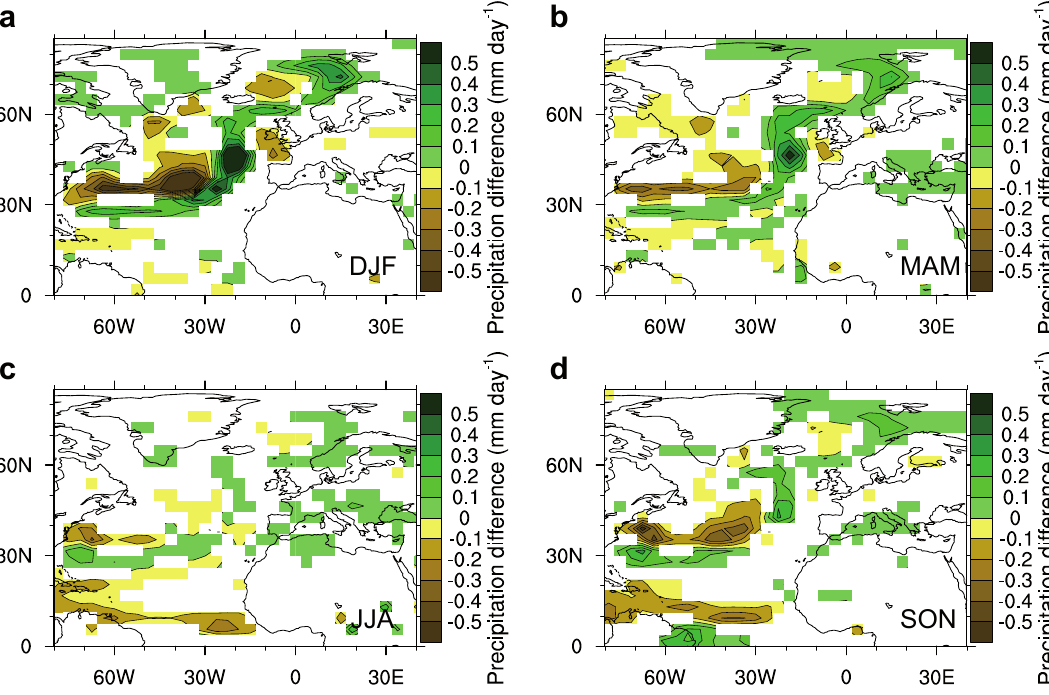
Fig. 11. Seasonal precipitation response for the Type 3 transitions according to the first method: (a) winter (DJF), (b) spring (MAM), (c) summer (JJA), (d) autumn (SON). Only the values that are statistically significant at the 5% level based on the two-sided Student’s t-test are